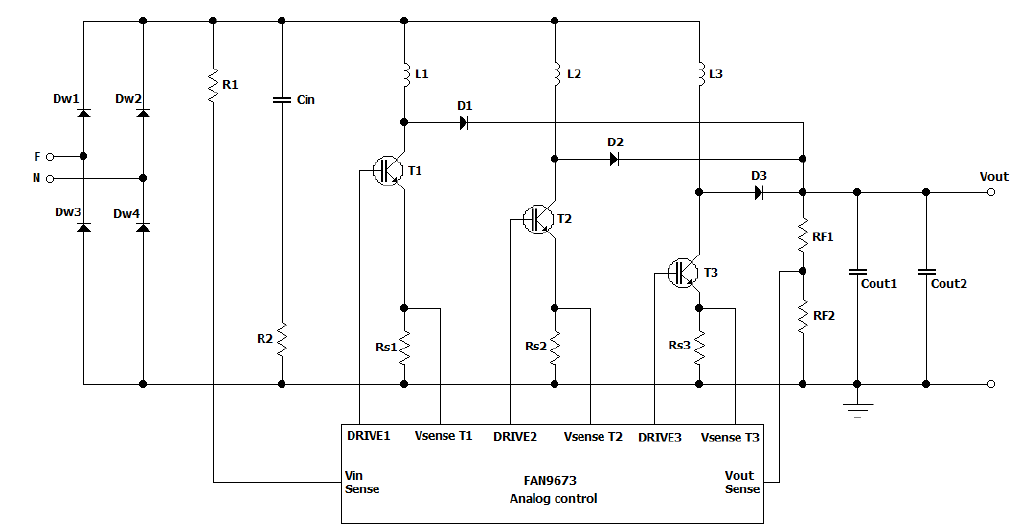
Figure 5. The circuit diagram of the high-voltage power supply unit (PSU) subsystem.